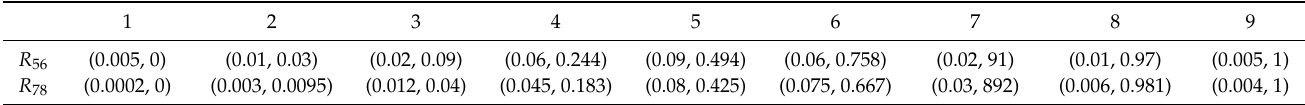
Table 5. Parameters of the membership functions designed for R 56 and R 78 .